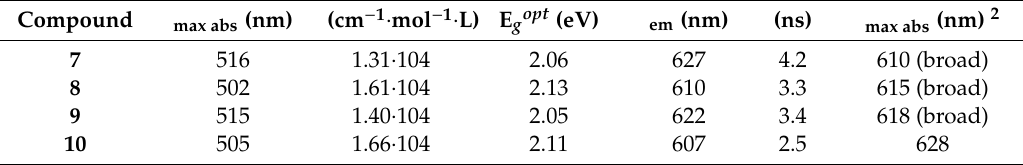
Compound Table 1. Photophysical properties in solution and in the solid state for oligomers 7 – 10 . 1